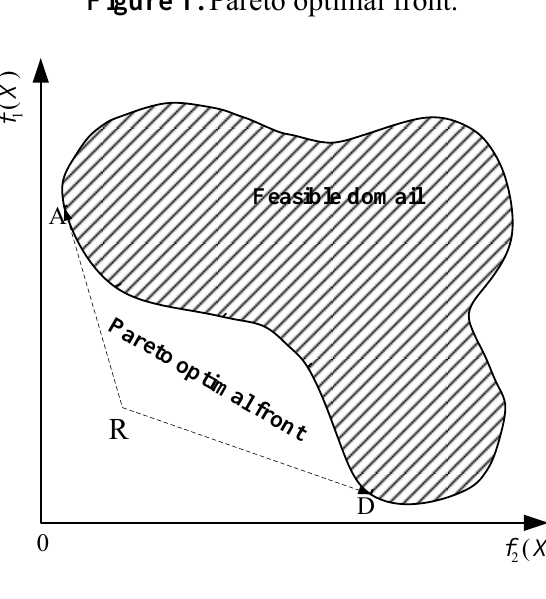
Figure 1. Pareto optimal